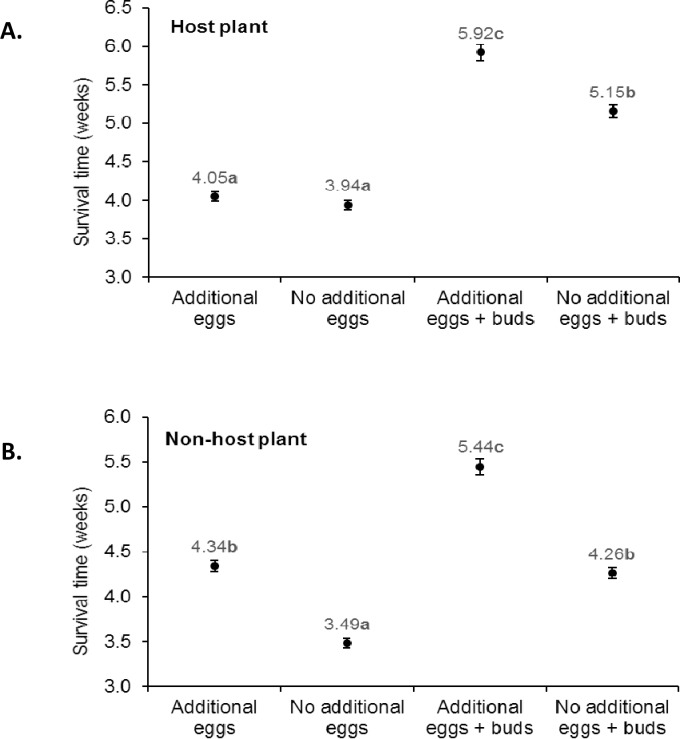
Nymph survival time for core brood that hatched from egg masses collected on (A) host plants or (B) non-host plants. Core brood were assigned to one of four treatments, with or without additional eggs and with or without flower buds as food. Points labeled with identical letters did not differ significantly (Weibull analysis, P>0.05). Vertical bars indicate 95% confidence internal.